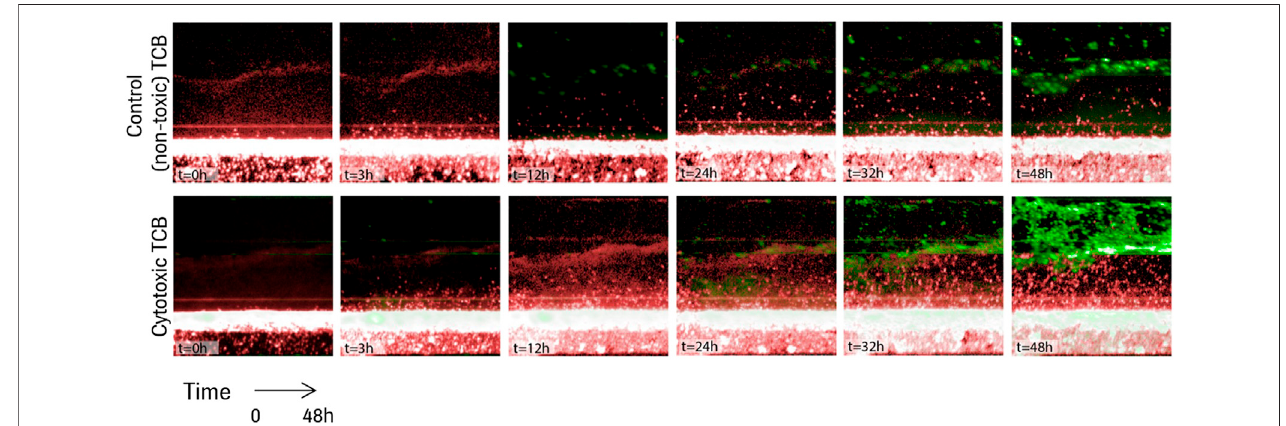
FIGURE 3 | Time lapse images for the fi rst 48 h of two representative experiments in the presence of a control TCB, DP47 (top), and in the presence of a cytotoxic TCB, D66-ESK (bottom). In fi ltrating PBMCs are tracked in red while apoptotic epithelial cells are imaged in green.